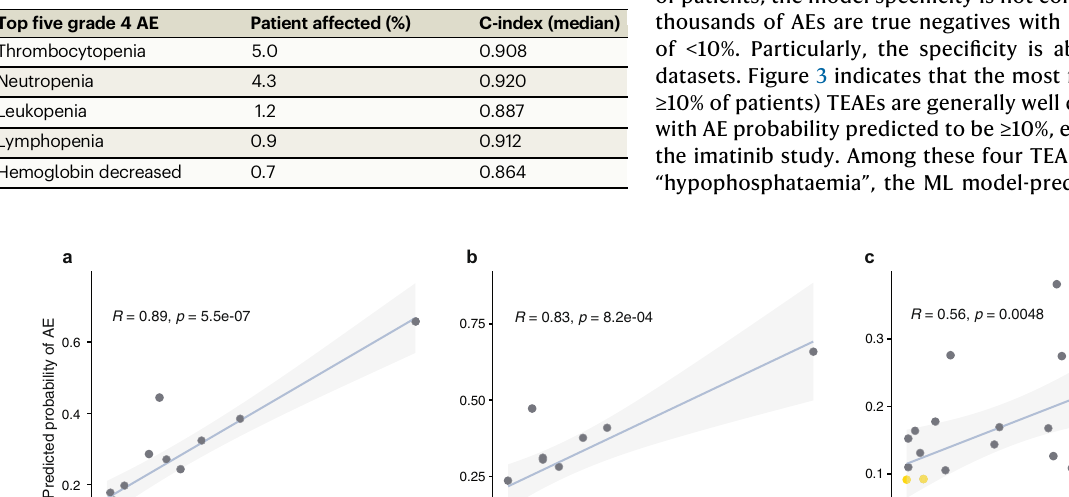
AEs predicted to occur in ≥ 10% of study subjects. On each plot, the blue line represents the fi tted linear regression line, and the gray band represents the 95% con fi dence interval; Pearson ’ s r (two-tailed) with p value is displayed. Yellow points represent four frequently reported TEAEs with predicted probabilities of <0.1; purple points AEs with both predicted probabilities and observed inci- dences of ≥ 10%.